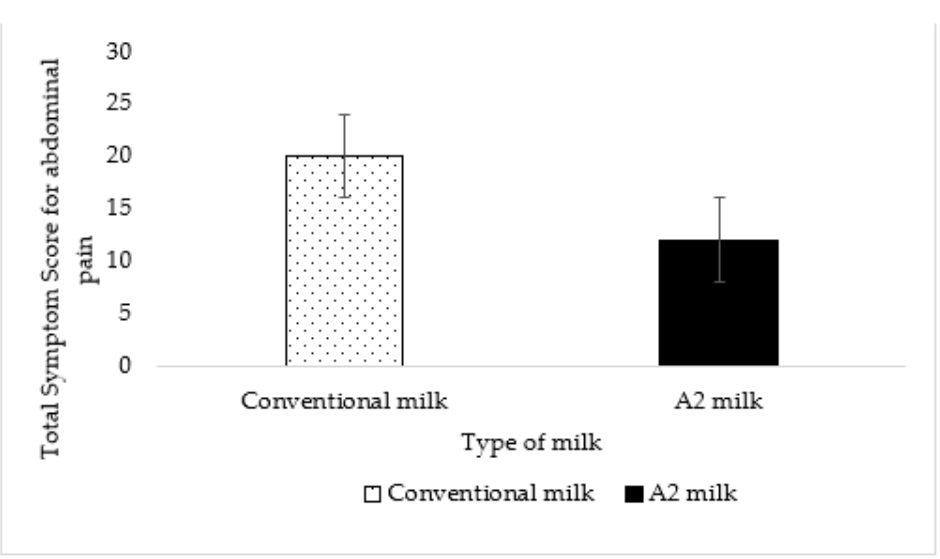
Figure 6. No effect or difference was detected in abdominal pain between A2 milk and conventional milk ( p = 0.19). The vertical lines in the graph indicate the standard error.